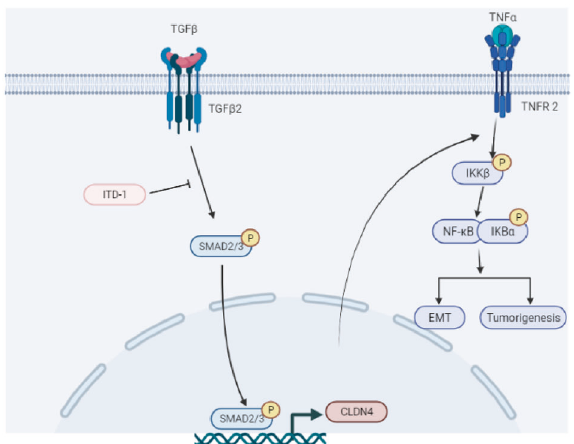
Fig. 8 Schematic diagram of the malignant phenotype mechan- ism of GBM mediated by CLDN4. CLDN4 plays a key role in the progression of GBM tumors. On the one hand, CLDN4 induces mesenchymal transition in GBM cells by regulating the NF- κ B signal pathway which is downstream signal pathway of TNF- α . On the other hand, the TGF- β /smad2 signal pathway can regulate the expression of CLDN4 and nuclear